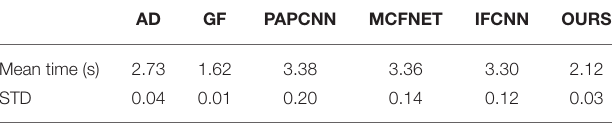
TABLE 3 | Average runtime comparison of different fusion methods.